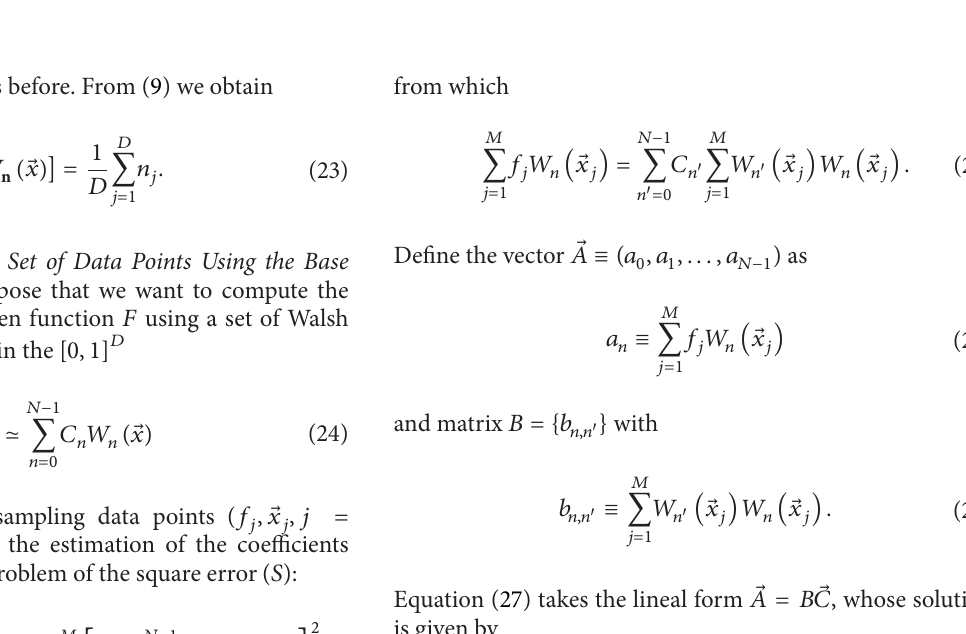
Figure 3: Approximation of two Walsh functions ( 𝑊 1 (𝑥) and 𝑊 2 (𝑥) ) using hyperbolic tangent functions combined with constant ones ( 𝐺 1 (𝑥) and 𝐺 2 (𝑥)